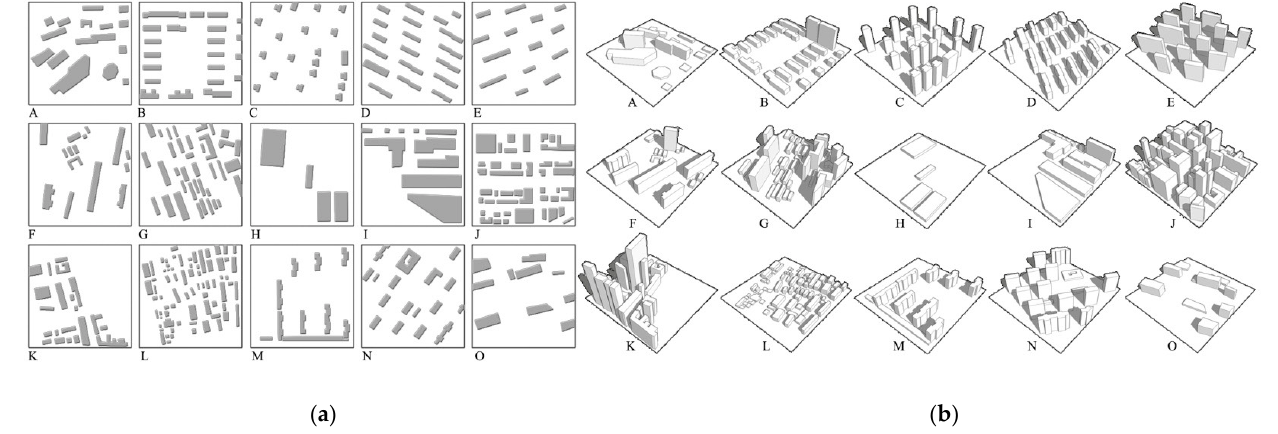
Figure 3. ( a ) Plans and ( b ) 3D models of the fifteen selected sites with different urban forms, each of 250 m × 250 m, where buildings are in grey, and open areas are in white (medical treatment areas: Site A; residential areas: Site B, C, D, E and M; industrial areas: Site H, I and O; commercial areas: Site J, K and L; mixed in different functional areas: F, G, and